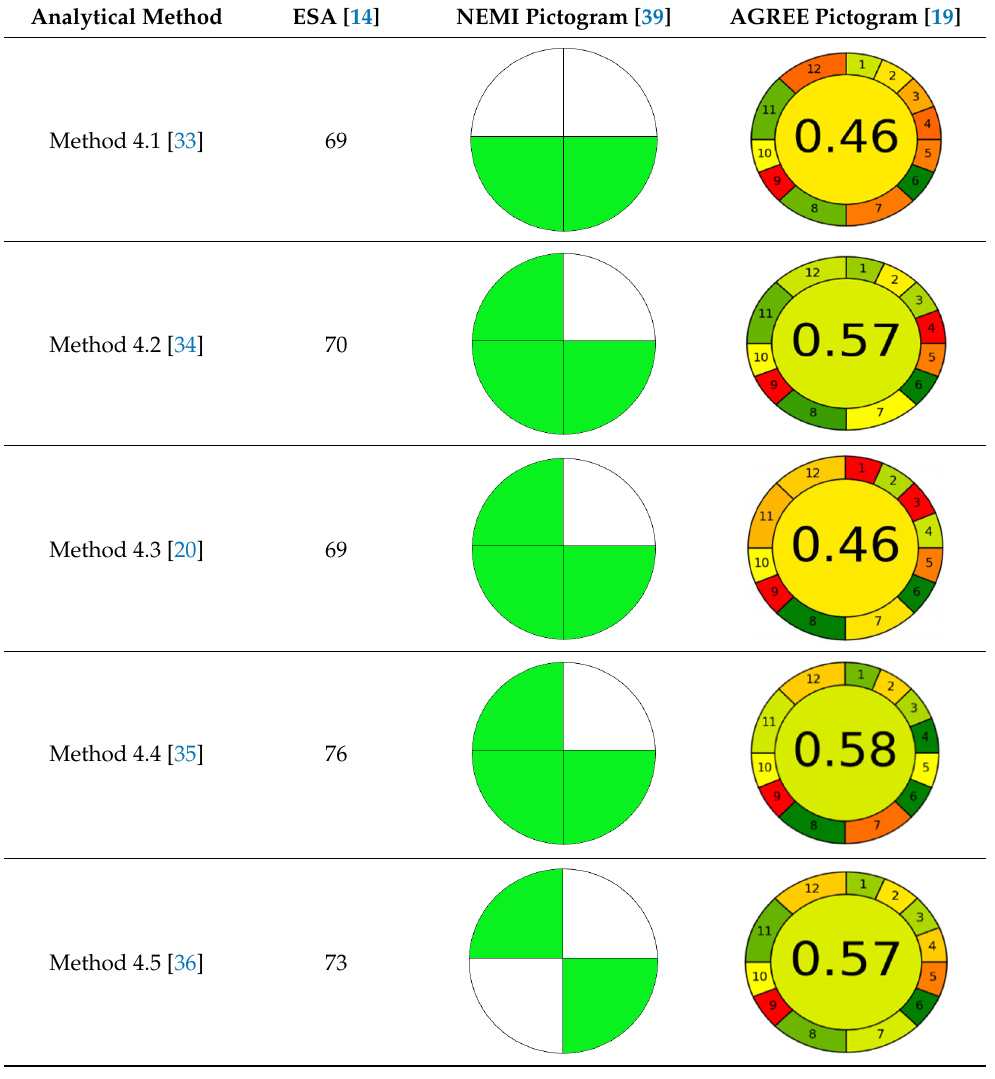
Table 4. Greenness assessment results of methamphetamine and heroin analytical procedures.